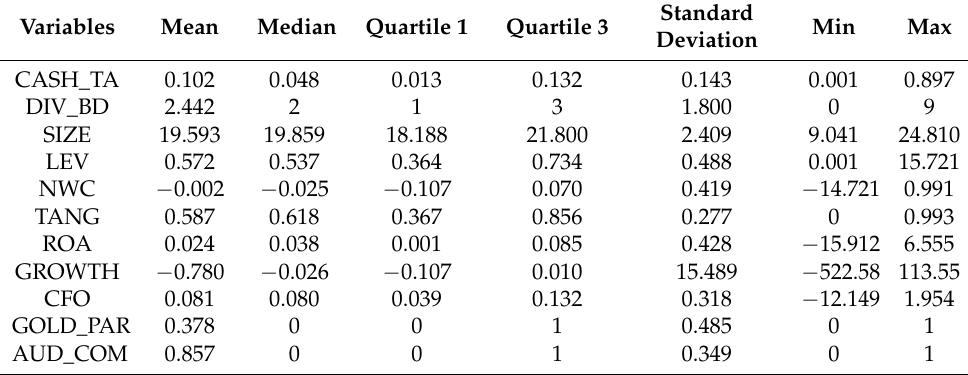
Table 1. Descriptive statistics of the full